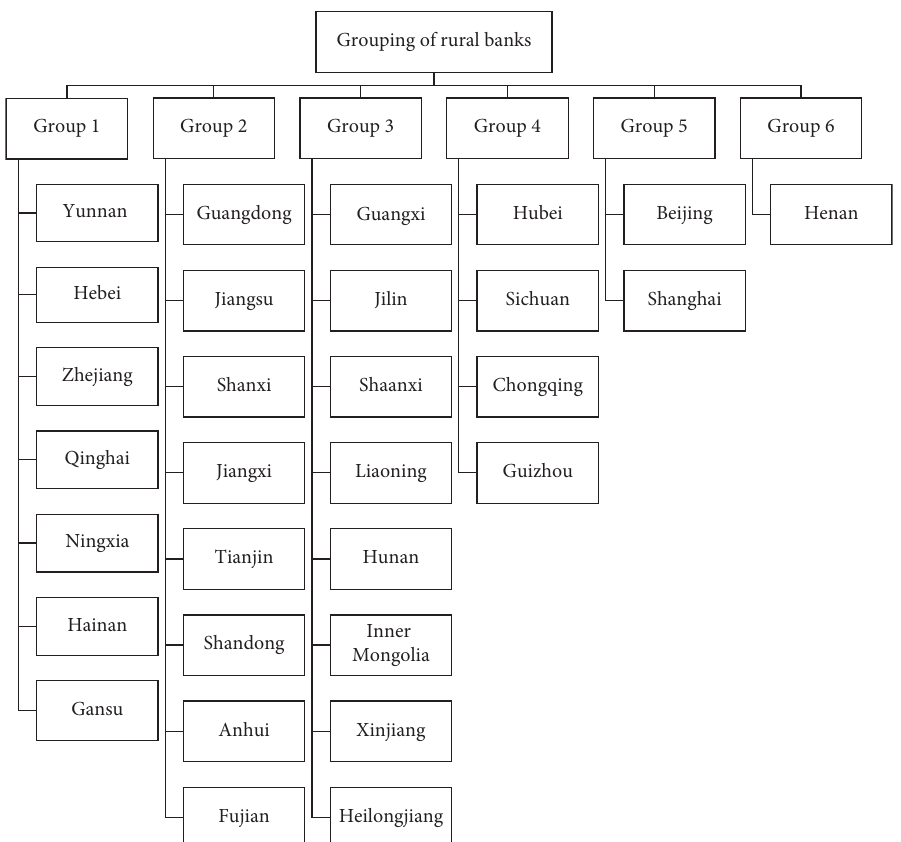
Figure 2: The clustering result of Birch